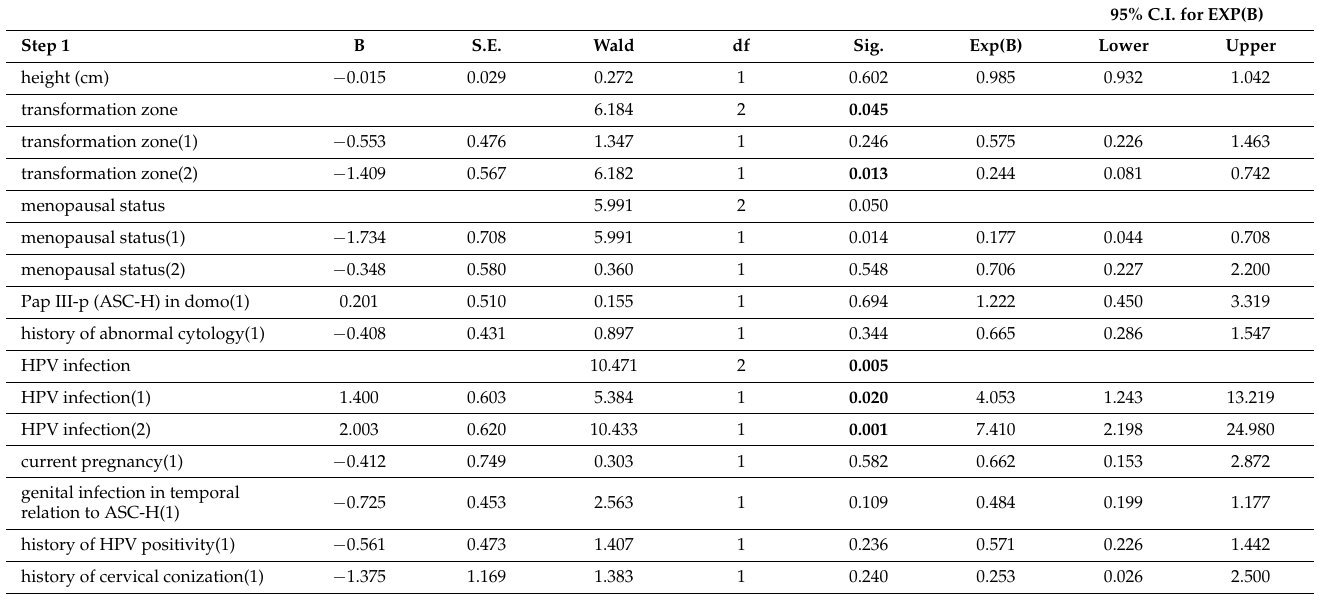
Table 3. Final multivariate logistic regression model.